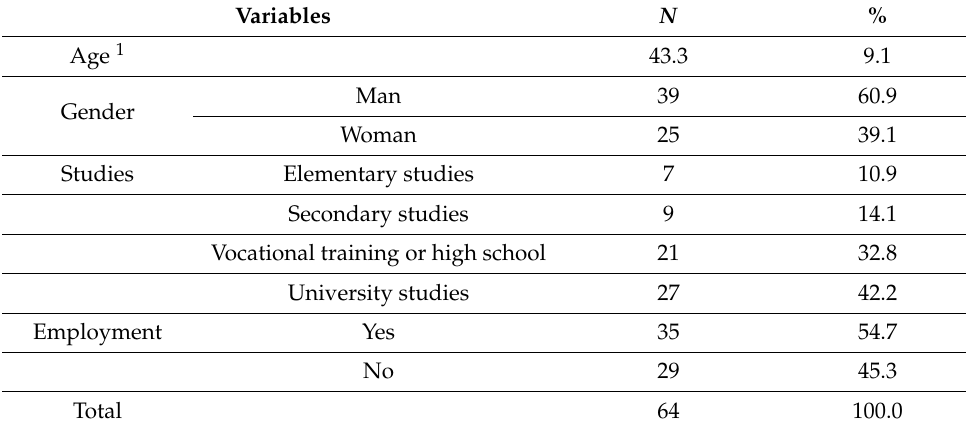
Table 1. Sociodemographic